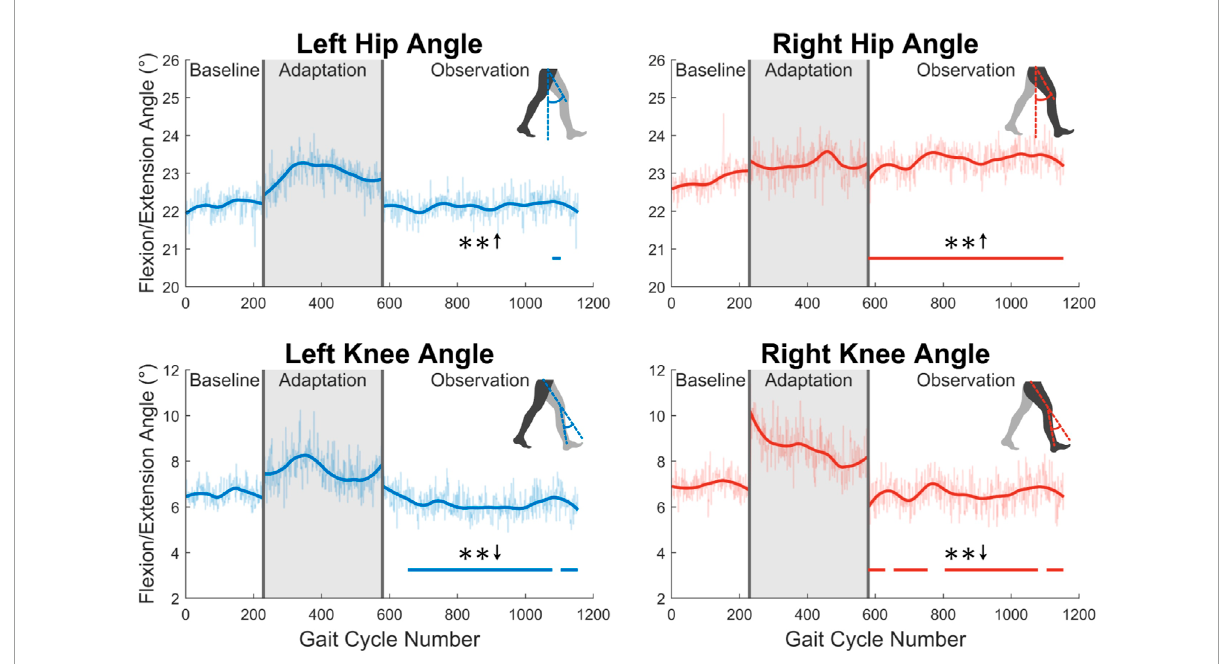
FIGURE 6 Hip and knee flexion/extension angles at heel strike for both left and right sides. Significance is shown in the observation phase as compared to the baseline phase by the significance line. All significance testing was performed on “unsmoothed” data (seen in the lighter line). The darker line is the data smoothed by 2nd-degree polynomial local regression and was added only to allow the reader to more clearly see trends in the